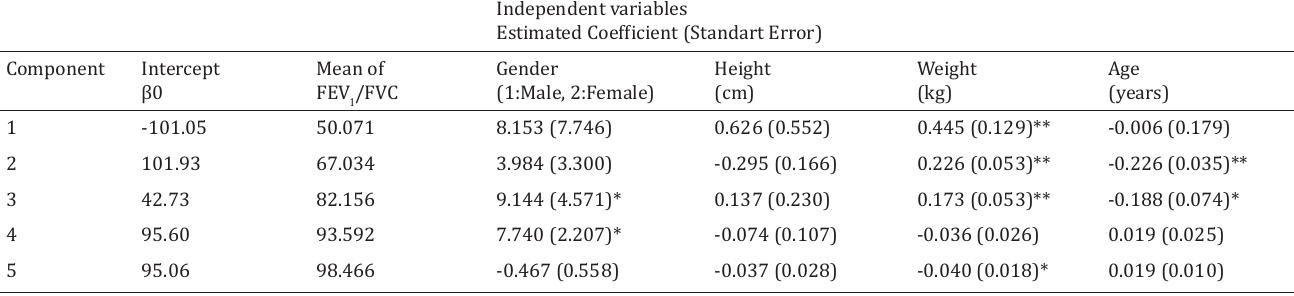
Parameter estimation and standard errors of components